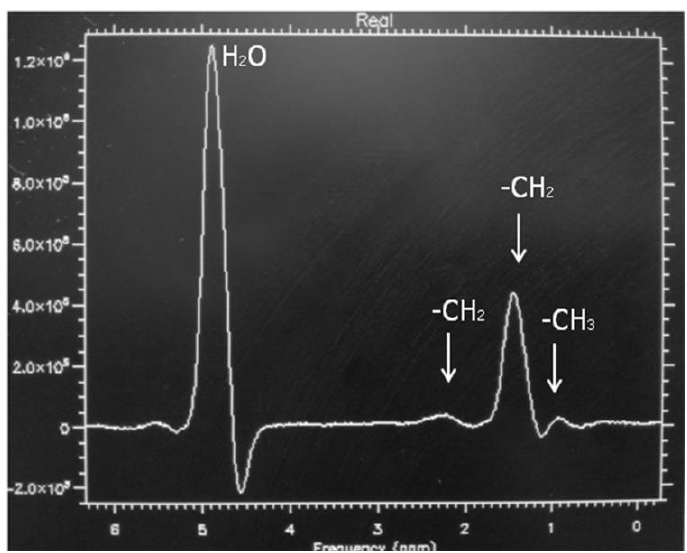
Figure 5. Magnetic resonance (MR) spectrum of a child with non-alcoholic fatty liver disease (NAFLD) and mild steatosis. Note the clear visualization of triglycerides peaks.